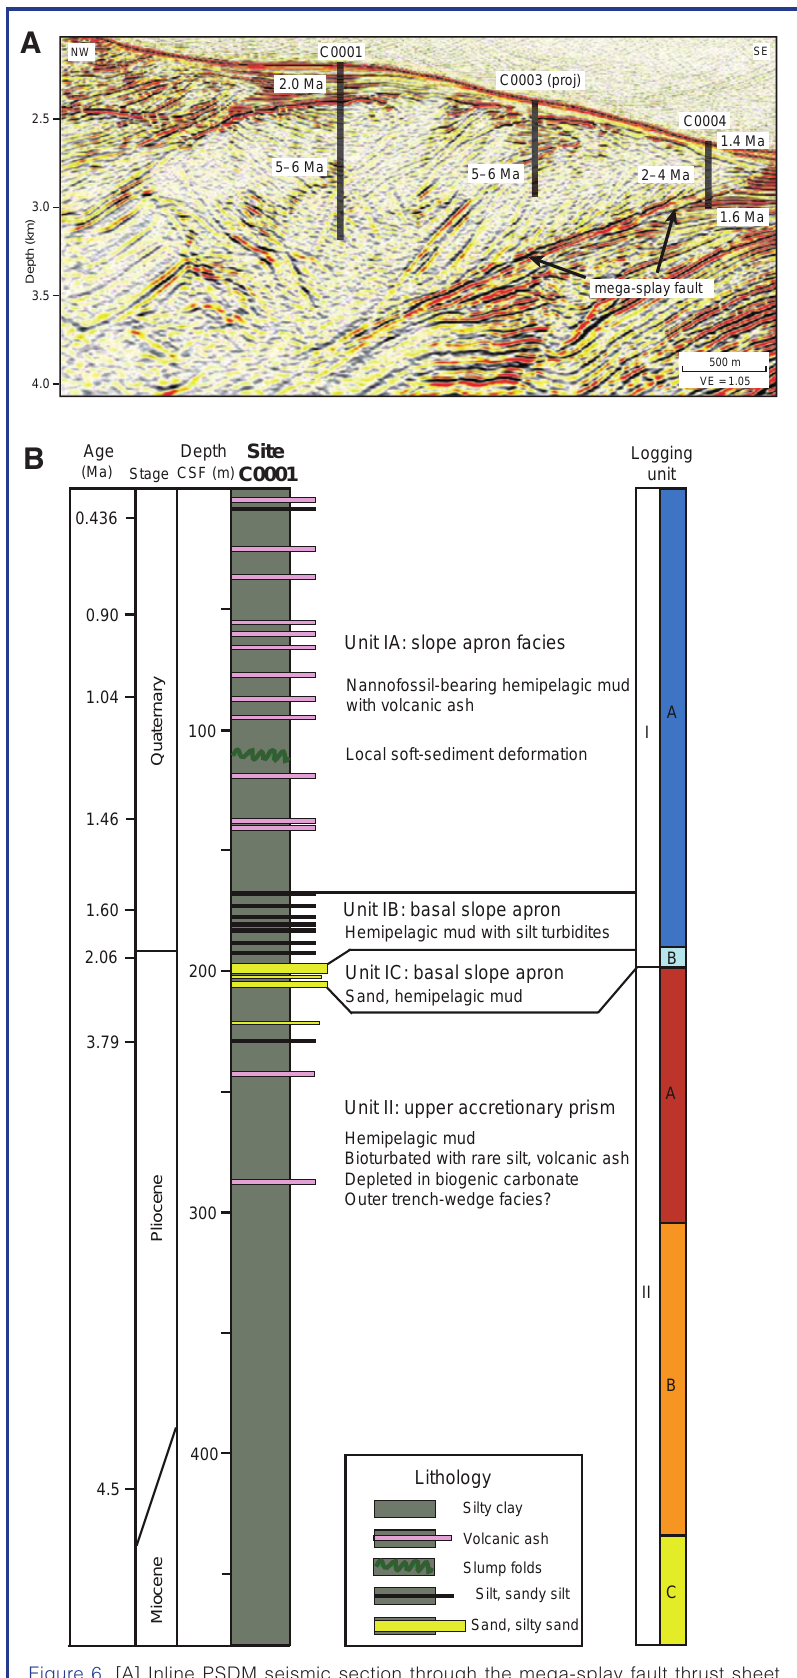
Figure 6. [A] Inline PSDM seismic section through the mega-splay fault thrust sheet sites, showing total drilled depth at each site. Age labels show maximum sediment depositional ages based on nannofossil biostratigraphy. [B] Site C0001 summary column of lithostratigraphy, logging units, and age of sediments determined through biostratigraphy and paleomagnetic